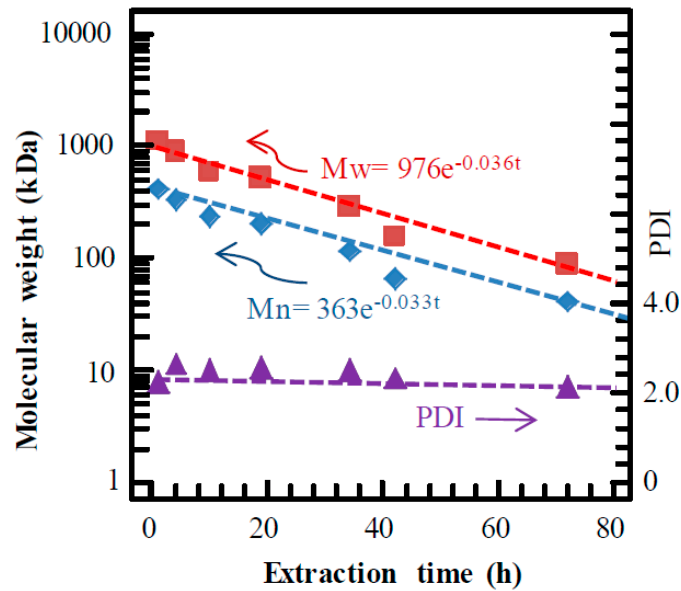
Figure 9. Relative molecular weight ( M w and M n ) and polydispersity index (PDI) of the extracted polystyrene graft chains calculated from Figure 8.